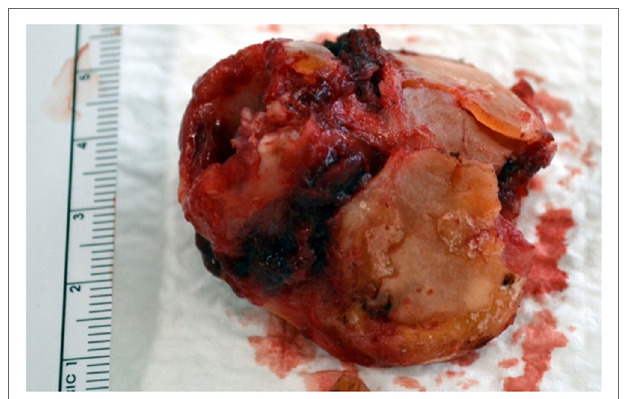
FigUre 5 | Laryngectomy specimen, essentially made of laryngeal cartilages.